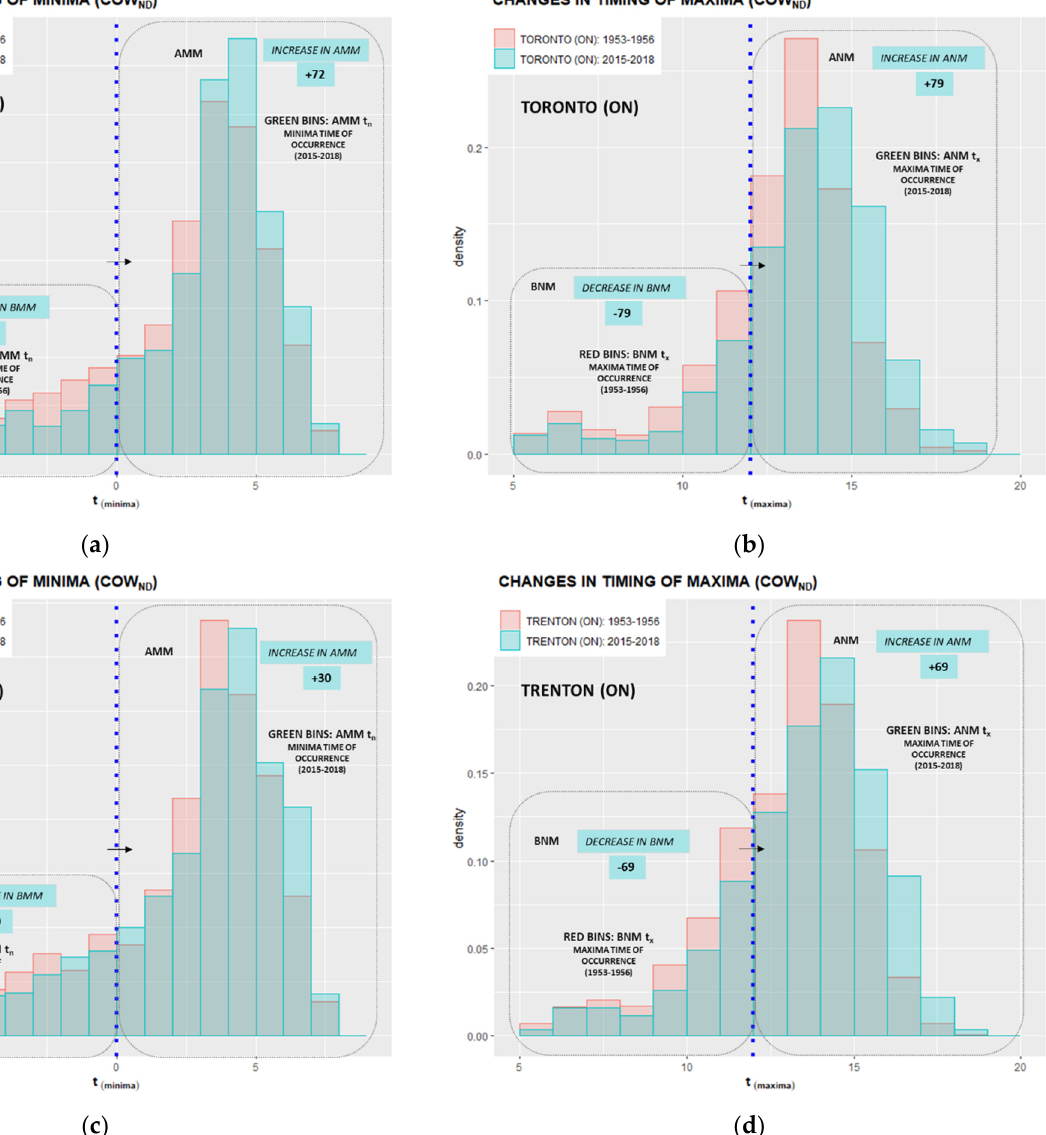
Figure 8. Time evolution of diurnal extrema timing histograms for the Great Lakes/St. Lawrence Lowlands climate region, at Toronto ( a , b ), and Trenton ( c , d ) stations. Migration of Before Midnight Minima (BMMt n ) to After Midnight Minima (AMMt n ) and Migration of Before Noon Maxima (BNMt x ) to After Noon Maxima (ANMt x ) between four-year averages at the beginning (1953–1956) and ending (2015–2018) of data ranges. The blue dotted line represents midnight delineation ( left ) and noon delineation ( right ).